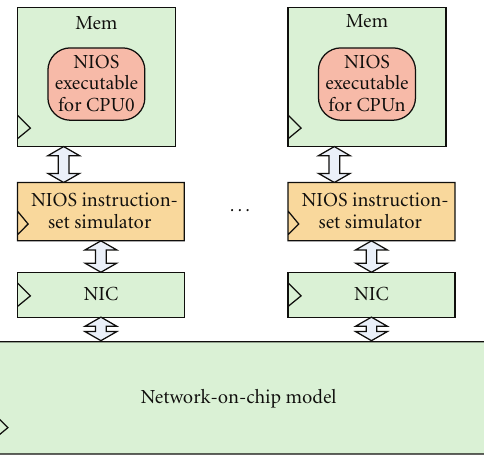
Figure 4: Logic design of a multi-soft-core virtual prototype.